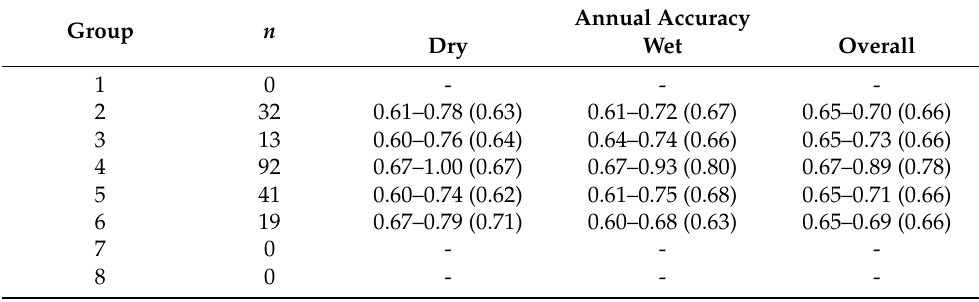
Table 3. Number ( n ) and accuracy range of parameter sets for each calibration group that met accuracy constraints for annual and monthly simulations. The ‘wet’ and ‘dry’ columns present the range of accuracy when MWBM stream permanence classifications are assessed on only wet SWPO or dry SWPO. The median accuracy value is displayed in